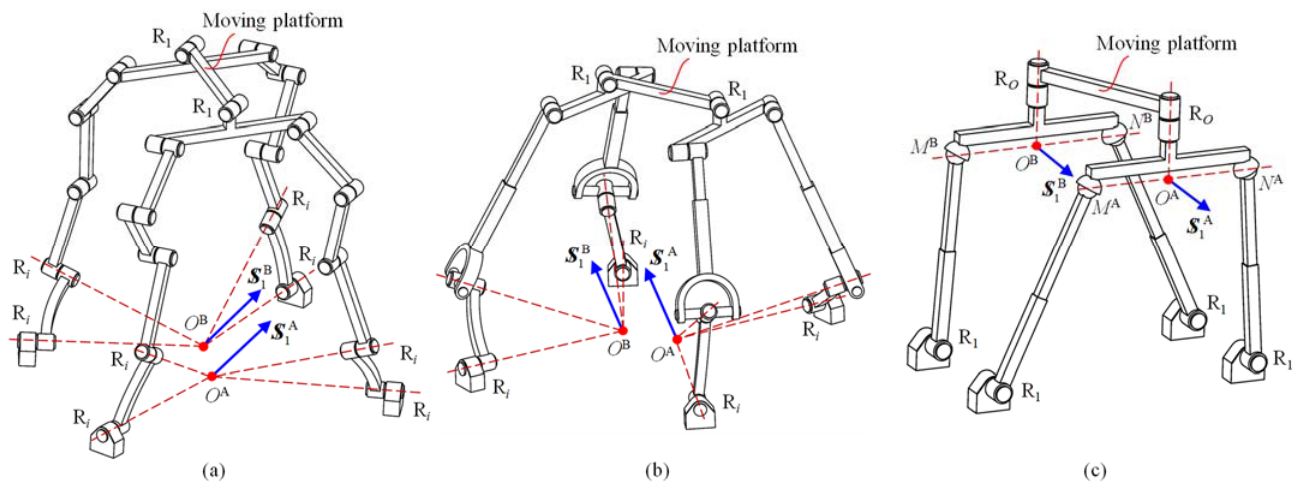
Figure 7. Typical non ‐ overconstrained 2R2T PMs: ( a ) 2([R i R i R 11 R 11 R 11 ‐ R i R i R 12 R 12 R 12 ] ‐ R 1 ) PM, ( b ) 2([R i UPR 11 ‐ R i UPR 12 ] ‐ R 1 ) PM, ( c ) 2([R 1 PS ‐ R 1 PS] ‐ R O ) PM.